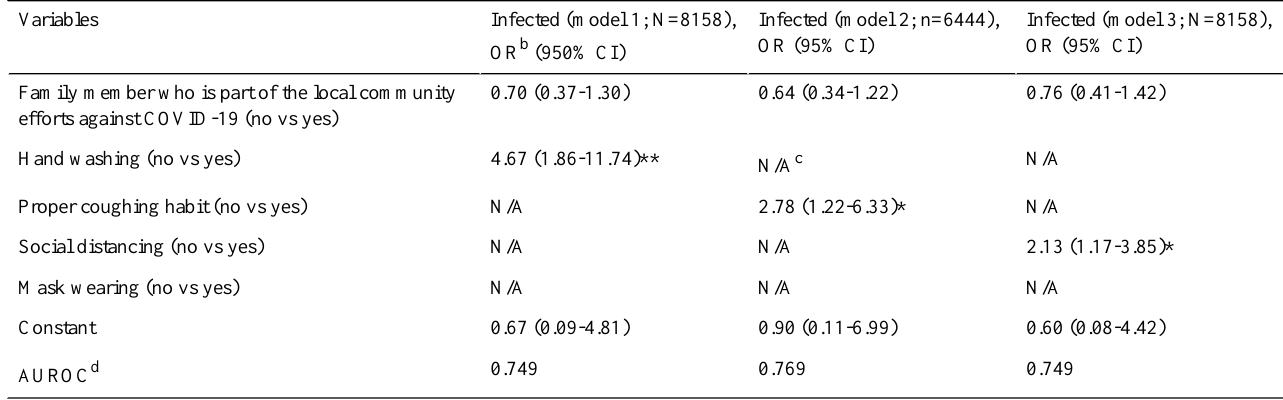
a Models 1-5 are models adjusting for social demographic variables plus handwashing, coughing habits, social distancing, mask wearing, and all four nonpharmaceutical interventions together, respectively. Model 6 is adjusting for social demographic variables only. For each model, the convergency of penalized maximum likelihood function was monitored, and coefficients and their 95% CIs were examined. Each model converged normally in a short period and no irregularity of coefficients and standard errors were identified.